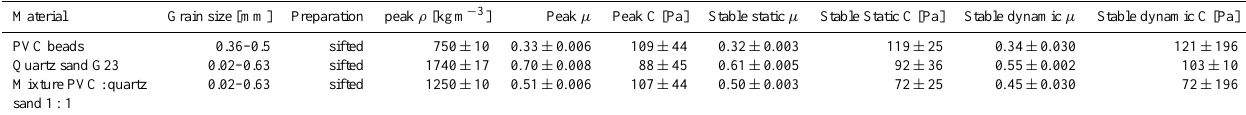
Table A1. Material parameters (density ρ , coefficient of internal friction µ and the cohesion C ) of used granular material measured with ring shear tester RST-01.pc.